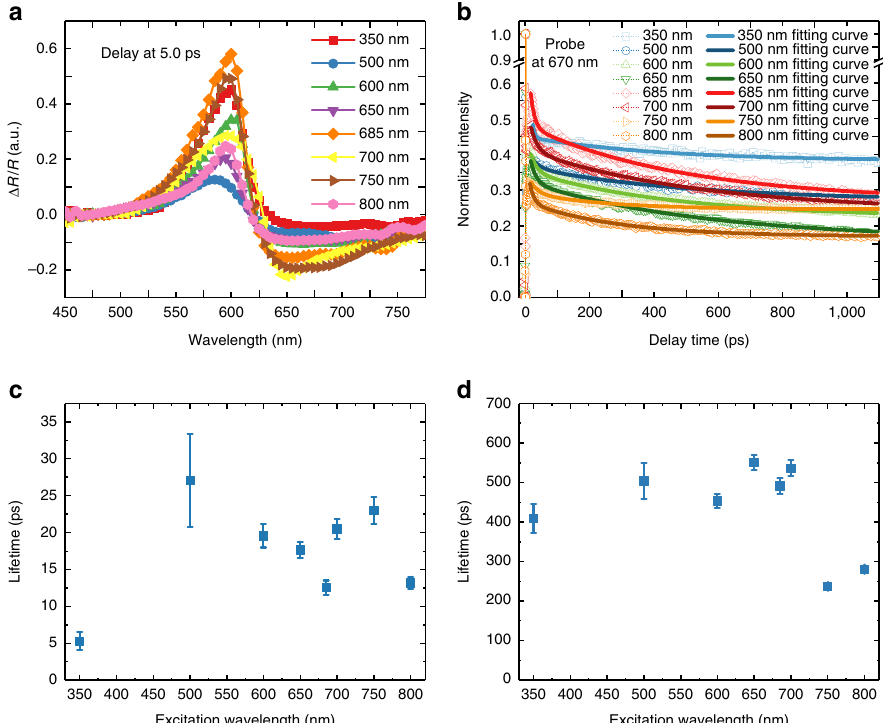
Figure 4 | The TA spectra of SrNbO 3 thin films. ( a ) The differential reflectance ( D R / R ) spectra for the SrNbO 3 film of the delay time at delays of 5.0ps with pump light of various wavelengths and a white light continuum probe. ( b ) The excitation wavelength-dependent dynamic spectra with the probe wavelength at 670nm with a measurement range of 1,100ps. The excitation wavelength-dependent carrier lifetimes are shown for two processes with the probe pulse at 670nm: ( c ) the fast process corresponding to the electron–electron scattering and ( d ) the slow process corresponding to thermal dissipation.